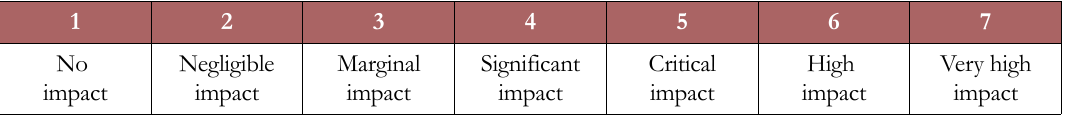
Table 1. Questionnaire